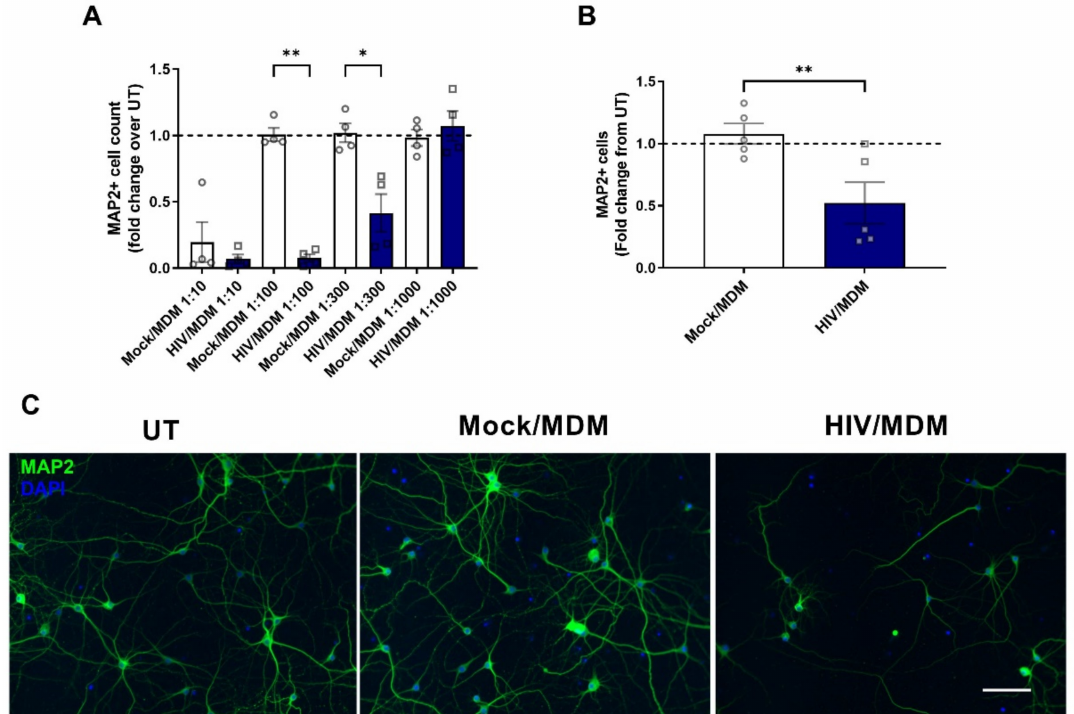
Figure 1. HIV/MDM supernatants treatment leads to neurotoxicity. Cells were fixed 24 h after treatment with Mock or HIV/MDMs. HIV/MDM supernatants derived from donor ND527 led